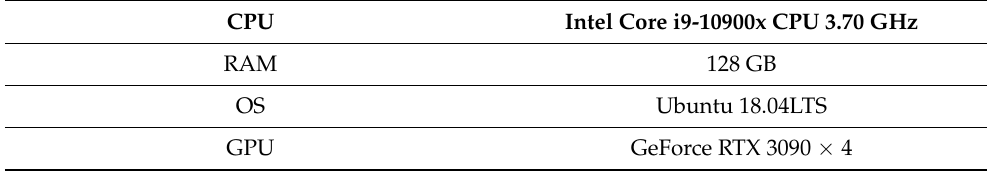
Table 2. High-performance PC specifications.